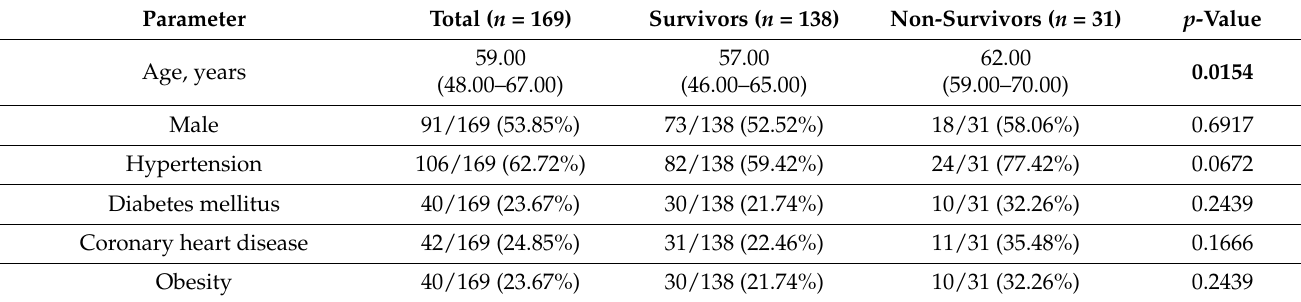
Table 1. Baseline characteristics of hospitalized patients with